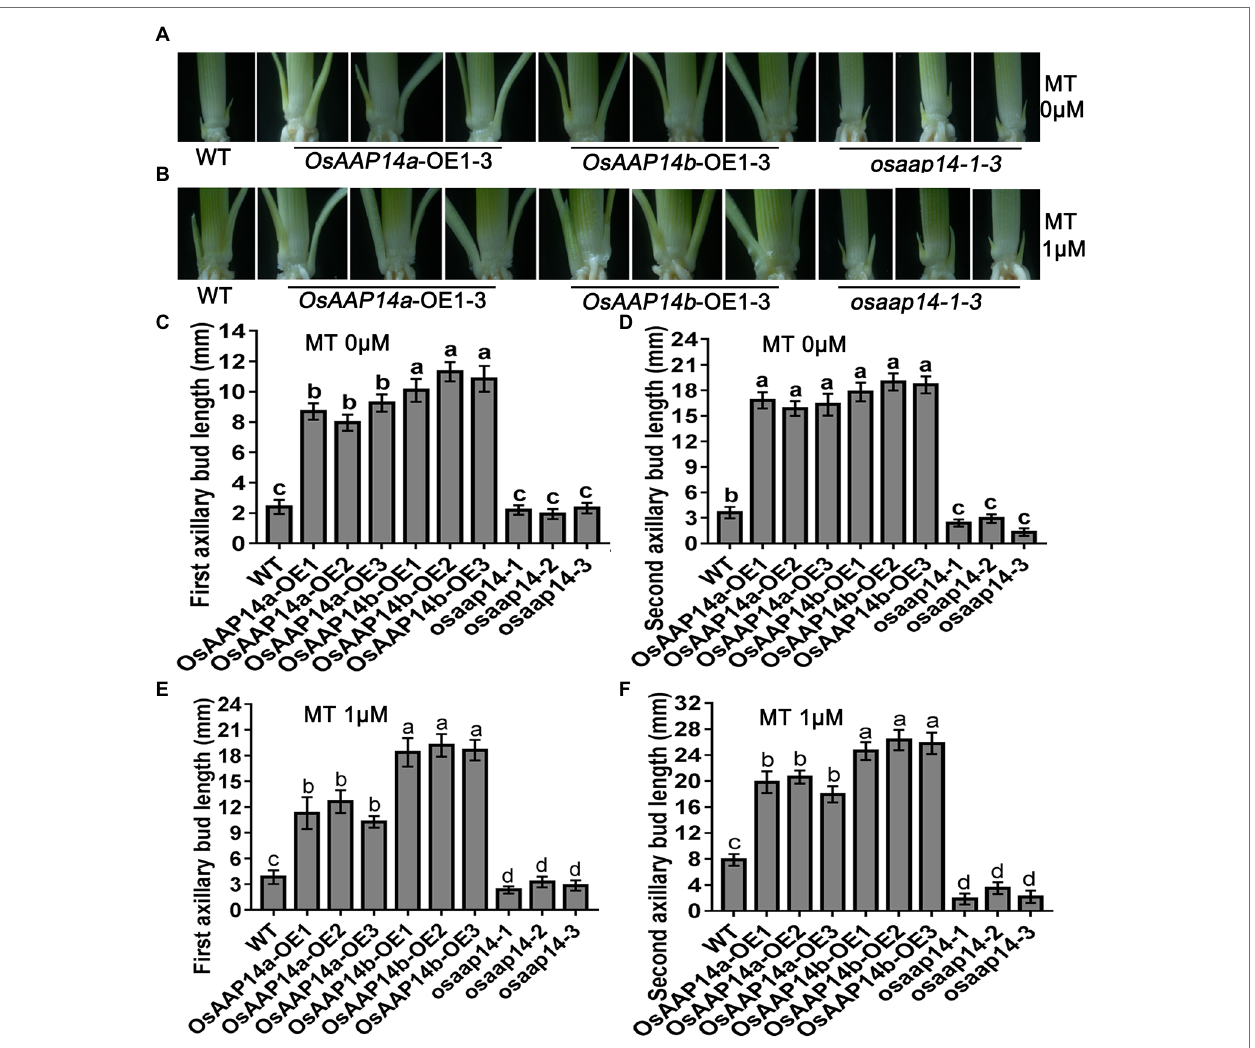
FIGURE 9 | Effect of melatonin on outgrowth axillary bud of OsAAP14 transgenic seedlings. Phenotypes of outgrowth axillary bud with altered expression of OsAAP14 grown under 0 μ m melatonin (A) and 1 μ m melatonin (B) . Statistical analysis of the first (C,E) and second (D,F) axillary bud length in (A,B) . Values are means ± SD ( n > 20), and the significance levels of different lowercase letters were as follows, p < 0.05. WT represents wild-type ZH11, OsAAP14a- OE1-OE3 represent three lines of OsAAP14 longer splicing variant over-expressing transgenic plants, OsAAP14b- OE1-OE3 represent three lines of OsAAP14 shorter splicing variant over-expressing transgenic plants, and osaap14-1-3 represent three lines of OsAAP14 CRISPR mutants. MT represents